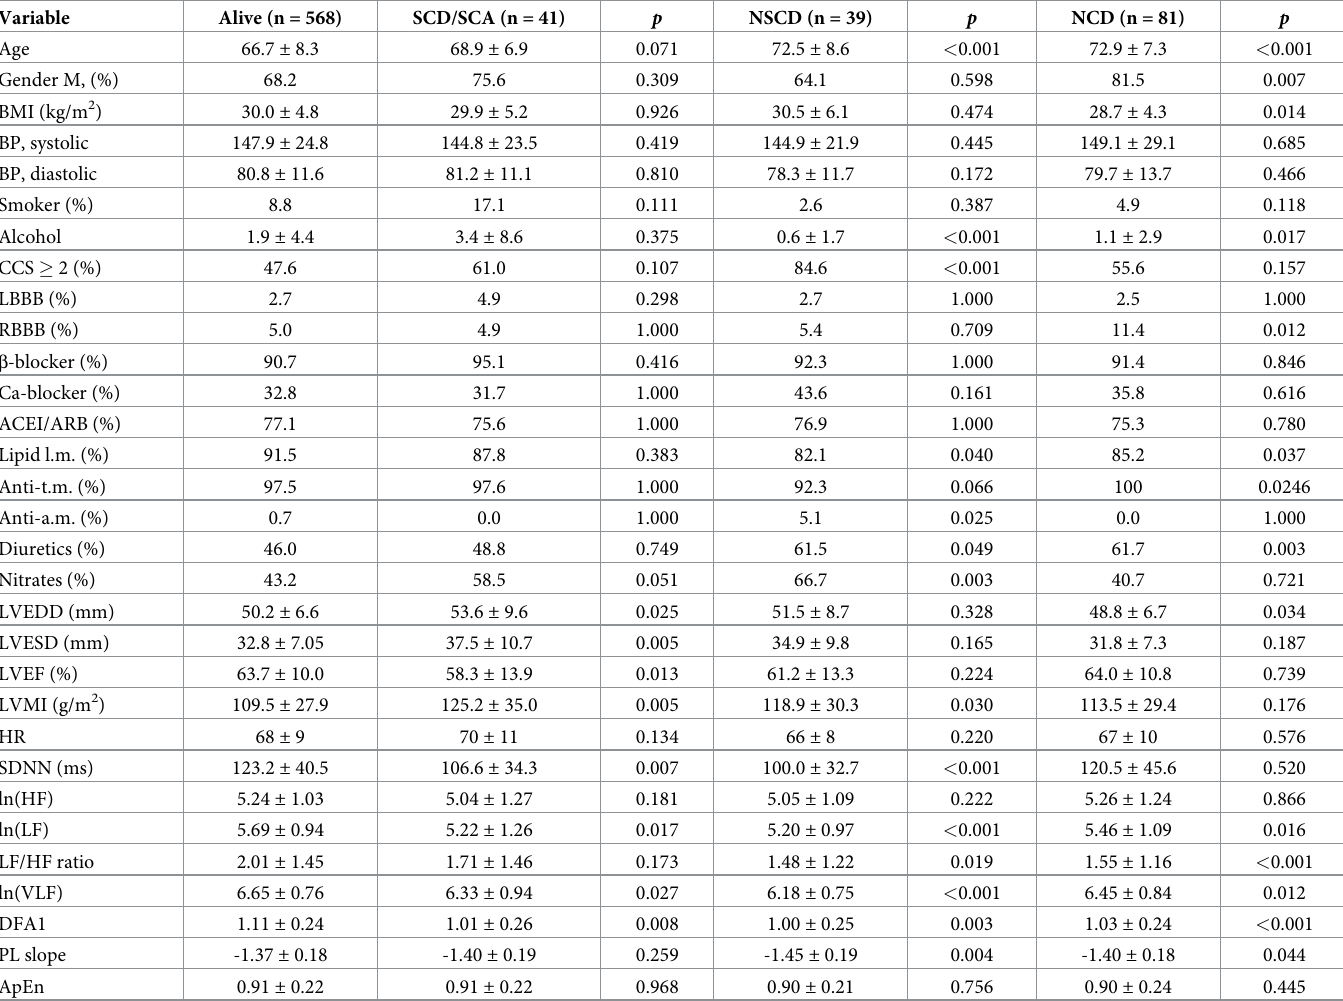
Table 4. Clinical characteristics and heart rate variability parameters in study patients with diabetes at